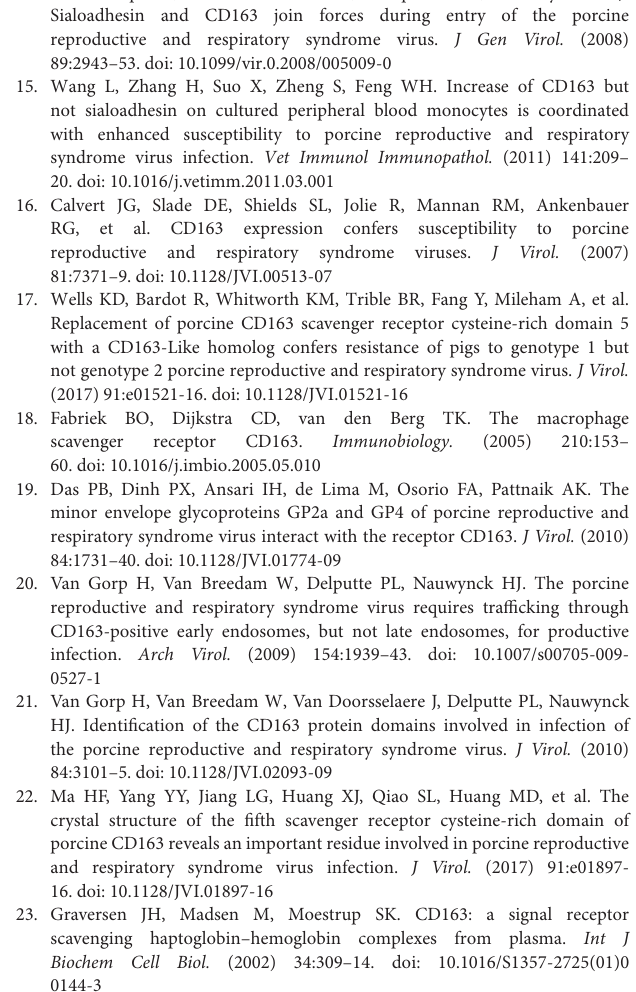
Figure S1 | Dual fluorescence selection of PEFs transfected with paired sgRNAs. (A) The fluorescent images of PEFs 24 h after transfection of plasmids pX458-sgRNA10 and pX458R-sgRNA134. Bar = 100 µ m. (B) Flow cytometry analysis of PEFs 48h after transfection of plasmids pX458-sgRNA10 and pX458R-sgRNA134. 10.9% PEFs derived from Liang Guang Small Spotted pig and 4.7% PEFs derived from Large White pig expressing dual fluorescent proteins. Figure S2 | Genotypes of CD163 edited healthy piglets. (A) Sequence analysis of clone PCR products of healthy Liang Guang Small Spotted piglets. (B) Sequence analysis of clone PCR products of healthy Large White piglets. Figure S3 | Schematic overview of generation of CD163 edited pigs through SCNT of PEFs from dual fluorescence selection. PEFs were transfected with Cas9/sgRNA co-expression vectors pX458-sgRNA10 and pX458R-sgRNA134 which contain reporter EGFP and DsRed, respectively. PEFs simultaneously expressing EGFP and DsRed were collected through fluorescence activated cell sorting. Then the sorting cells were introduced into enucleated oocytes, fused and activated. When the reconstructed cloned embryos developing to 2-cell stage were transferred into the oviduct of the recipient sows. In this diagram, the edited cells were derived from Liang Small Spotted pig, and Large White sows were used as